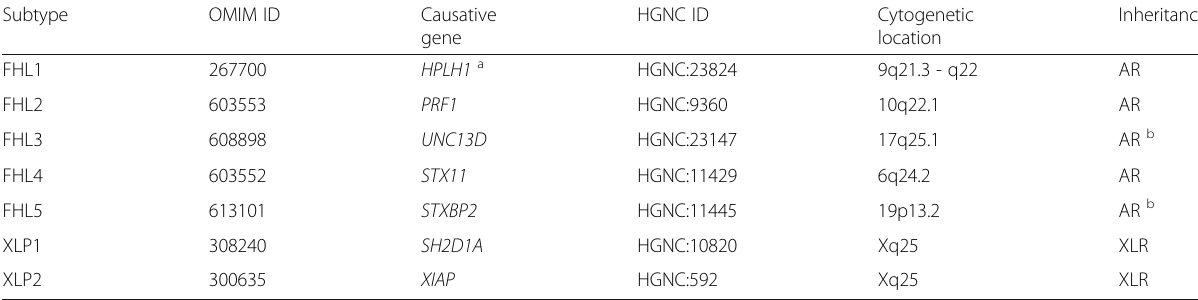
Table 1 Subtypes of familial hemophagocytic lymphohistiocytosis and X-linked lymphoproliferative syndrome Subtype